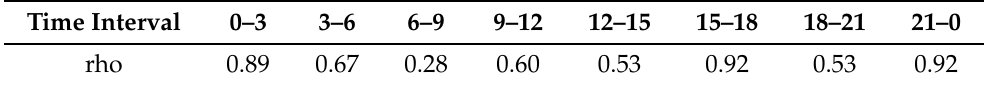
Table 3. Determined correlation coefficients ( p ≤ 0.0001) for time intervals of day on a county- wide